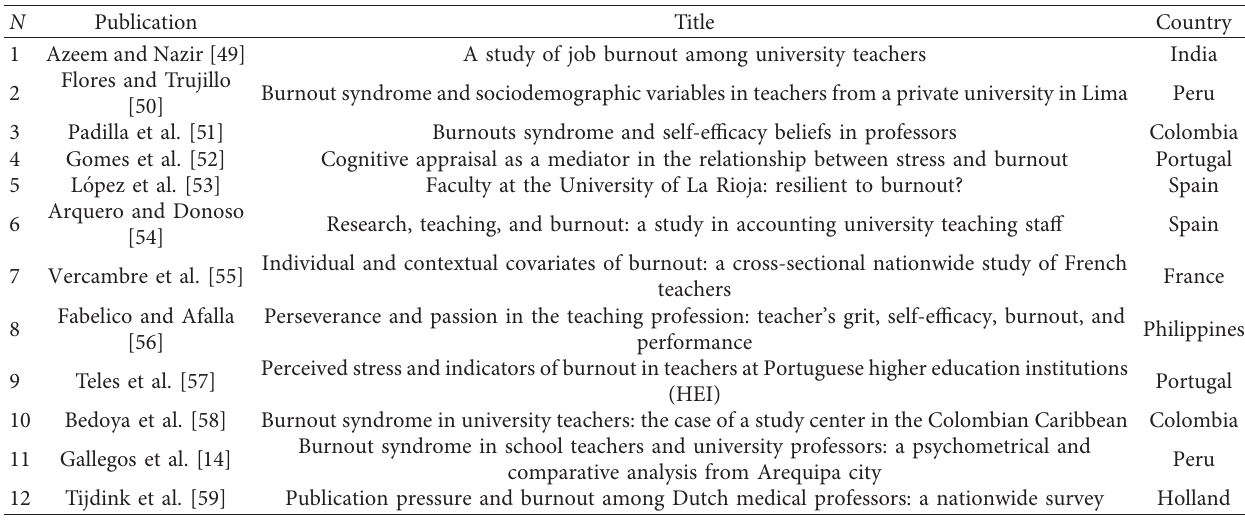
Table 3: Articles included in the systematic review.